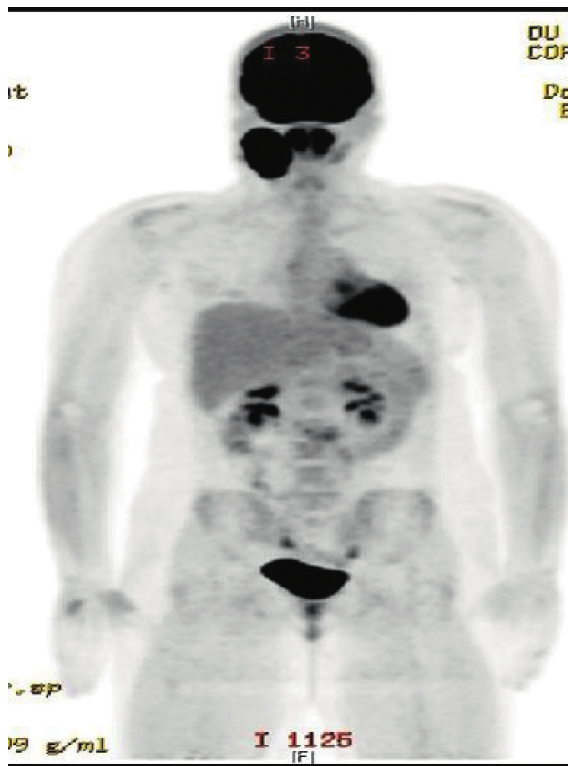
Figure 3: PET scan from a 17-year-old female showing a large FDG-avid right cervical mass, compatible with primary malig- nancy. No FDG-avid malignancy is identified elsewhere in the